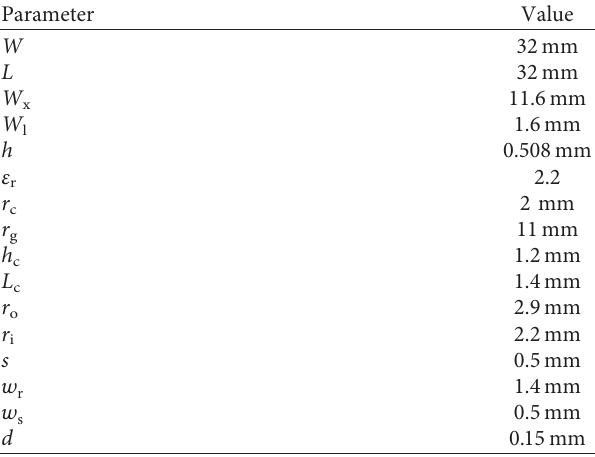
Figure 1: (a) Schematic illustrating the newly designed patch antenna: (b) simulated S antenna and newly designed patch antenna. Table 1: Geometrical parameters of the newly designed antenna.